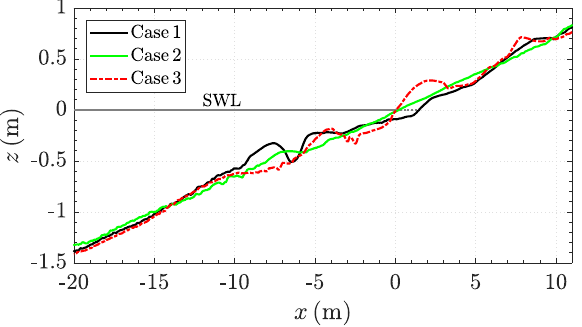
Figure 1. Initial morphologies of the three cases.